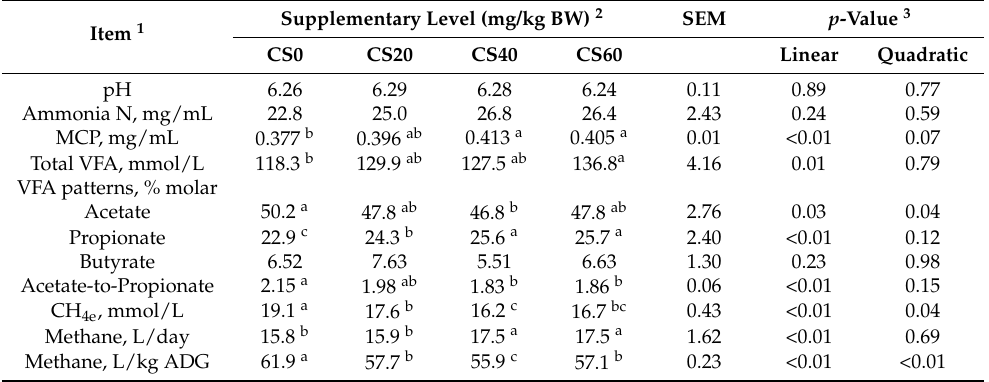
Table 4. Effect of dietary CS addition on rumen fermentation characteristics and methane